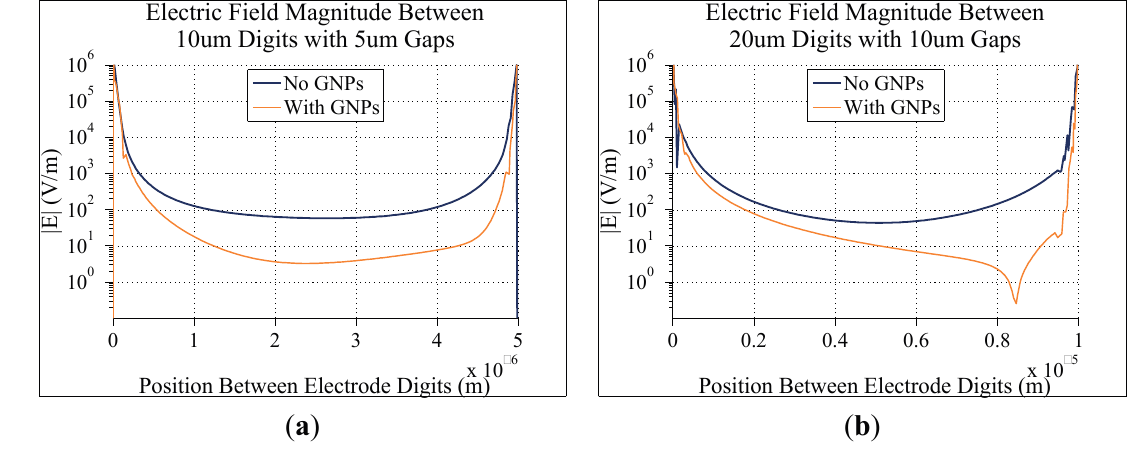
Figure 9. Graphs comparing the simulated electric field magnitude directly between two digits of electrodes with and without bound gold nanoparticles. In all cases, there was a background concentration of 10 mM KCl, and 0.1 V DC applied to the electrodes. The only differences between each graph are the dimensions of the electrodes: ( a ) 10 µm digits with 5 µm gaps; ( b ) 20 µm digits with 10 µm